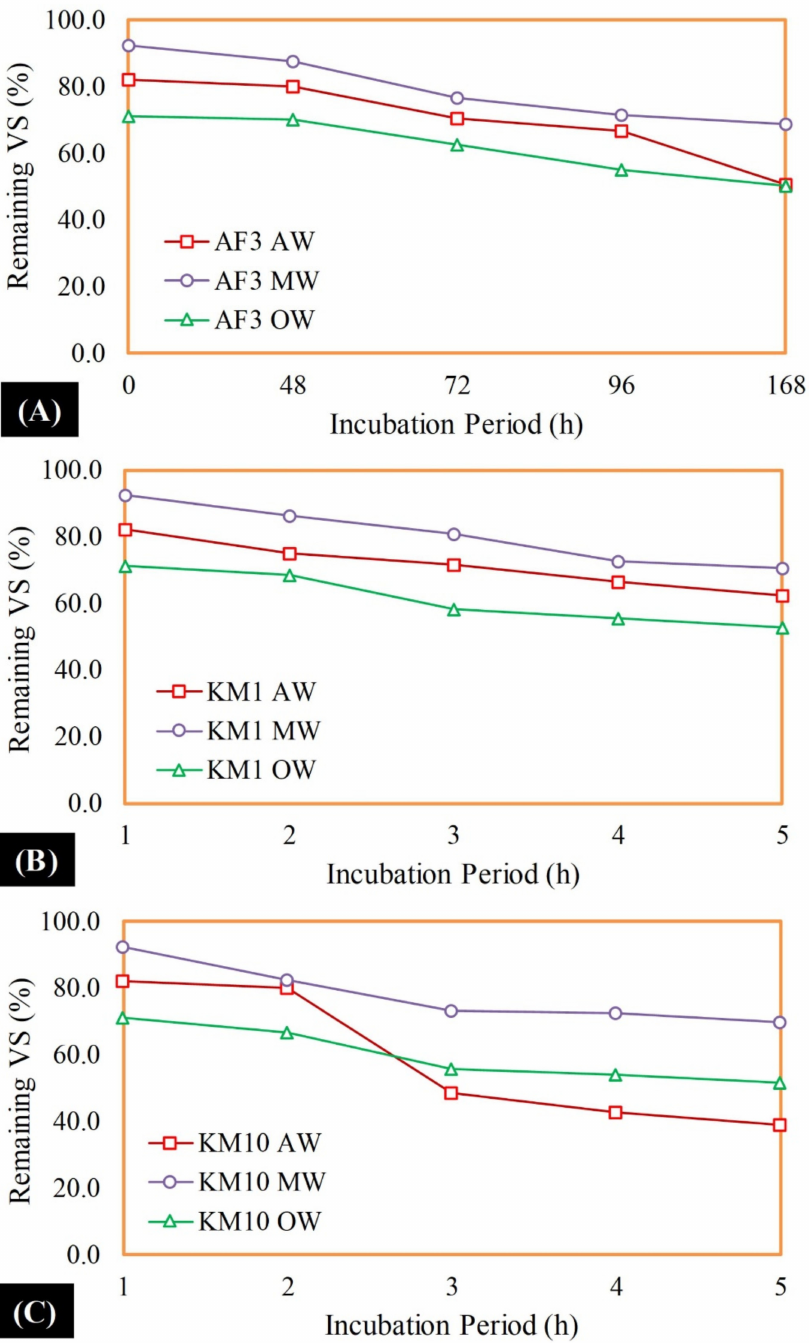
Figure 1. VS removal from the different waste types during aerobic biodegradation of the waste slurry by different bacterial strains; ( A ) AF3 strain, ( B ) KM1 strain, ( C ) KM10